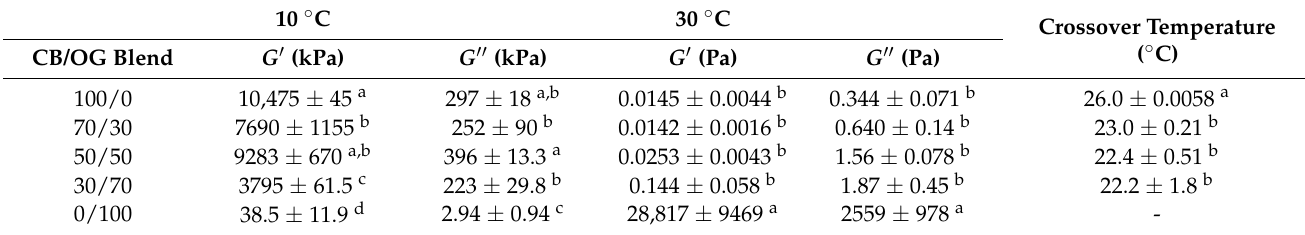
Figure 2. Viscoelastic moduli ( G (cid:48) : filled symbols; G (cid:48)(cid:48) : open symbols) at 1 Hz as a function of the temperature for the CB/OG blends. Stress ranged from 100 to 1000 Pa depending on the CB/OG blend measured. Table 4. Viscoelastic moduli at 1 Hz and at 10 and 30 ◦ C, and crossover temperature from temperature sweeps for the different formulated CB/OG